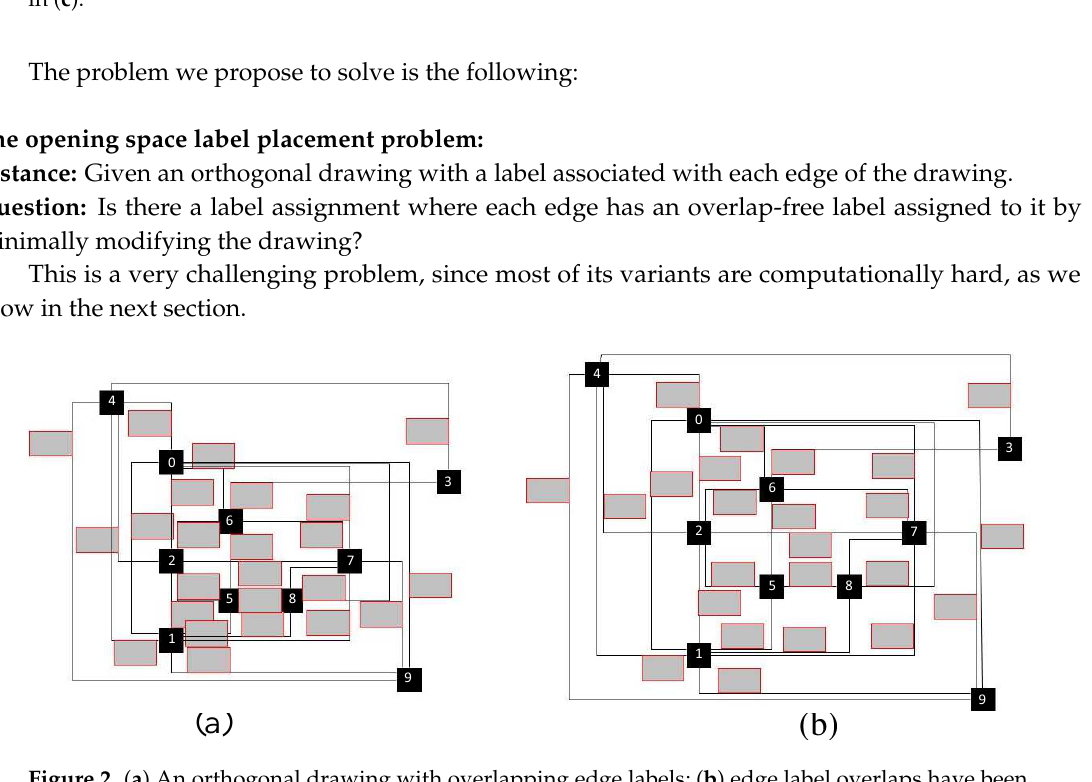
Figure 2. ( a ) An orthogonal drawing with overlapping edge labels; ( b ) edge label overlaps have been resolved by inserting extra space using our flow